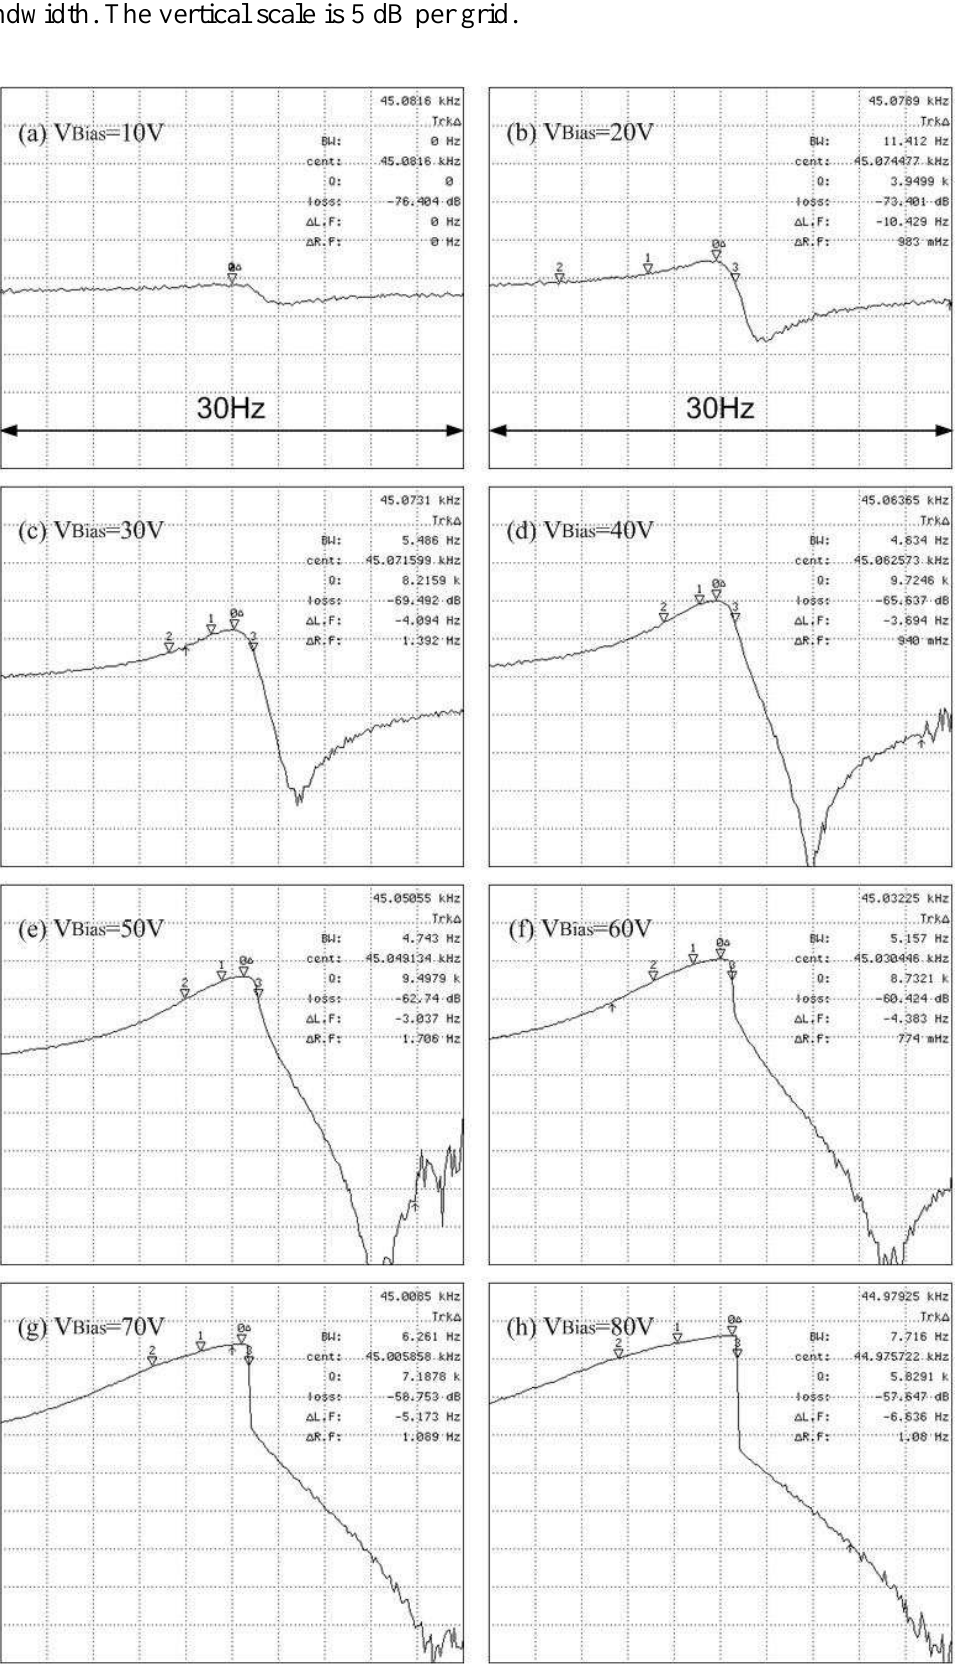
Figure 8. Magnitude plots for Device D 1 for bias voltages ranging from 10 V to 80 V. f The small inverse deltas mark the resonant frequency and frequencies at a 3 dB bandwidth. The vertical scale is 5 dB per